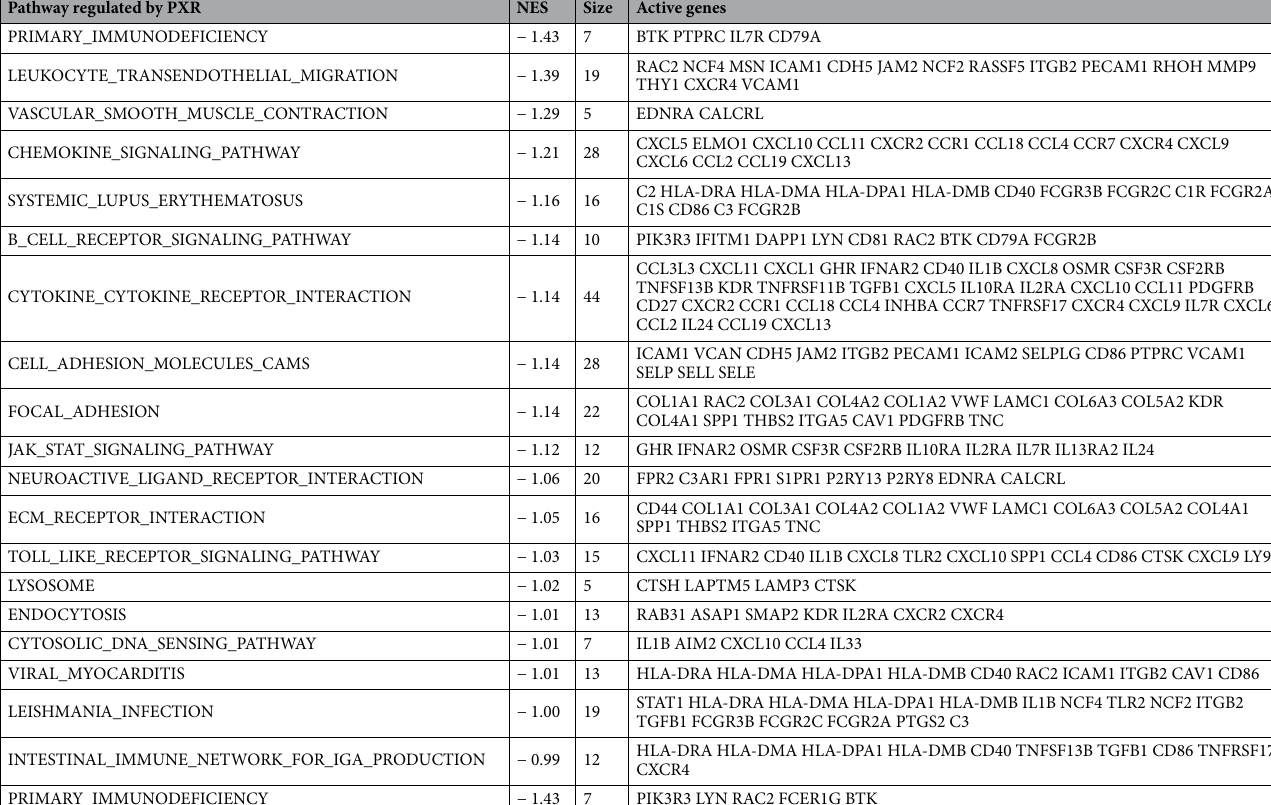
Table 2. Biological signal pathways and active genes in PXR low expression group by